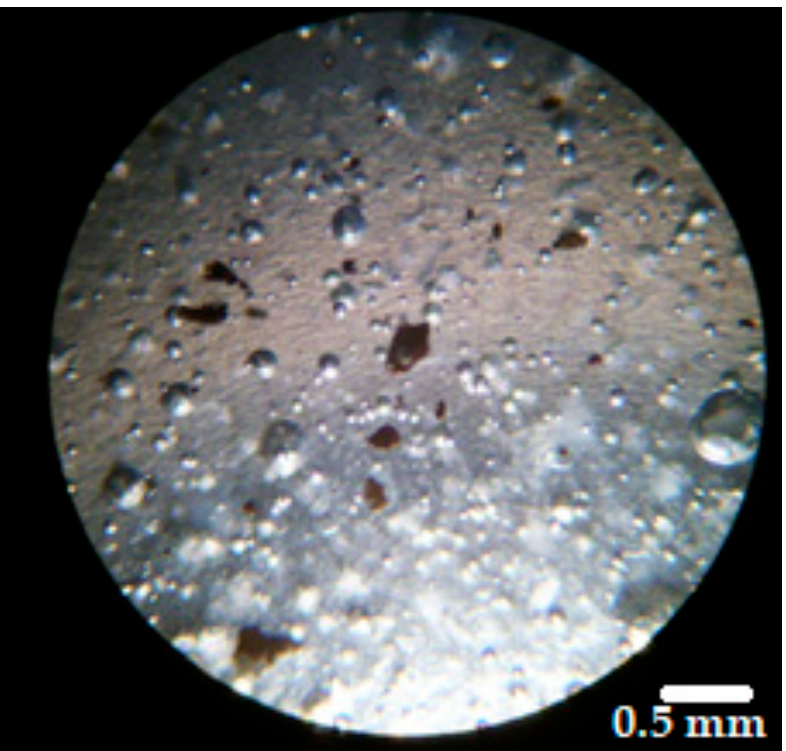
Figure 3. Microscopical image of the distribution of BGAuSP in the Vaseline ointment (magnification 40×).